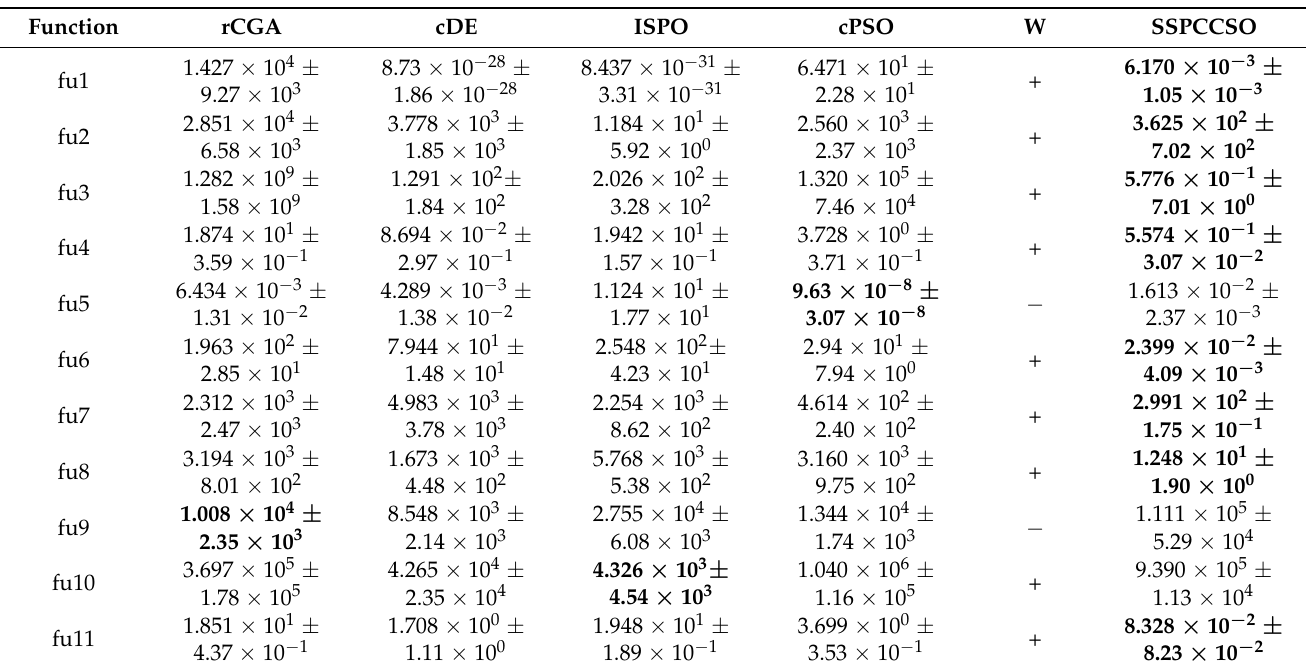
Table 3. Comparison for memory-saving